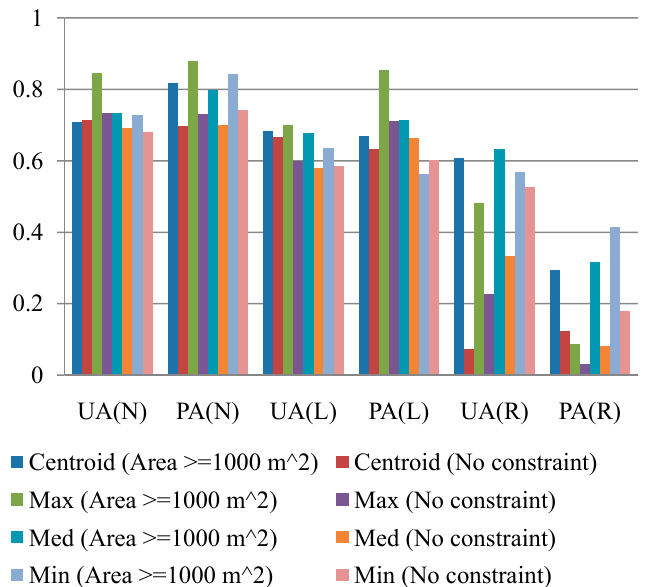
Figure 6. Quantitative evaluations of Model-1 using different sampling operators to compare the results of applying the constraint on the area size or not. UA—user’s accuracy, PA—producer’s accuracy, N—non-landslide class, L—landslide source class, R—run-out class.